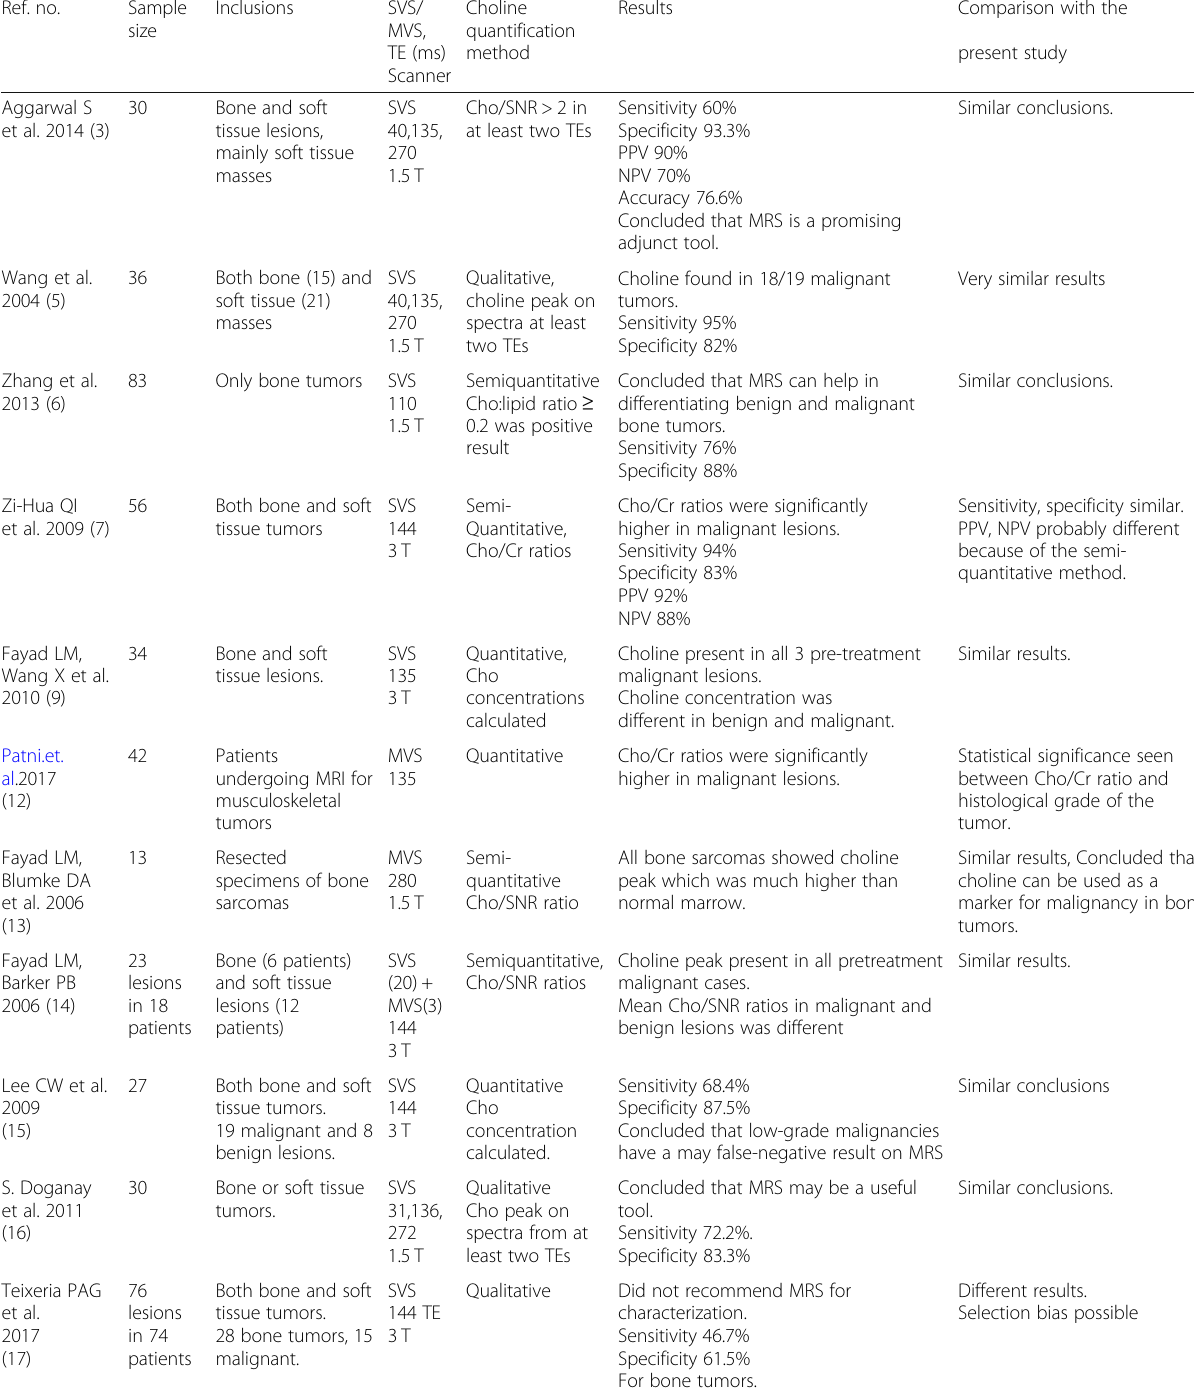
Table 4 Showing results and comparison of previous studies Ref.